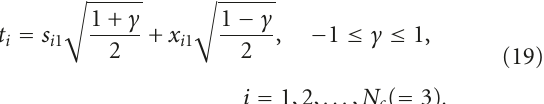
relay, meaning that no e ff ort was made on dealing